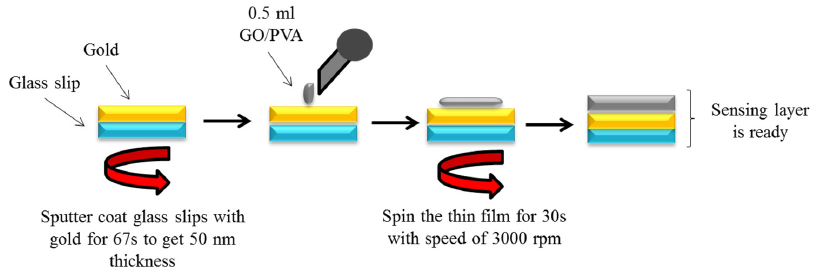
Figure 1. Schematic of preparing gold and sensing layer on thin film.